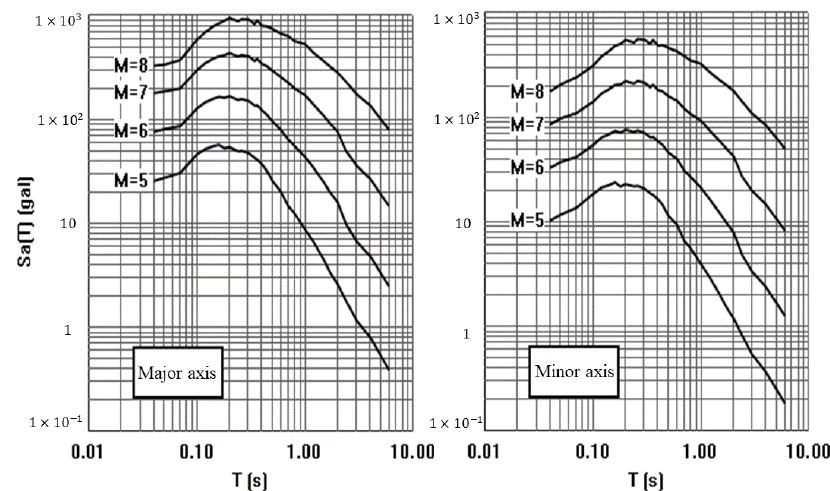
Figure 6. Attenuation curve of the response spectrum of horizontal bedrock acceleration (epicentral distance R = 50 km).